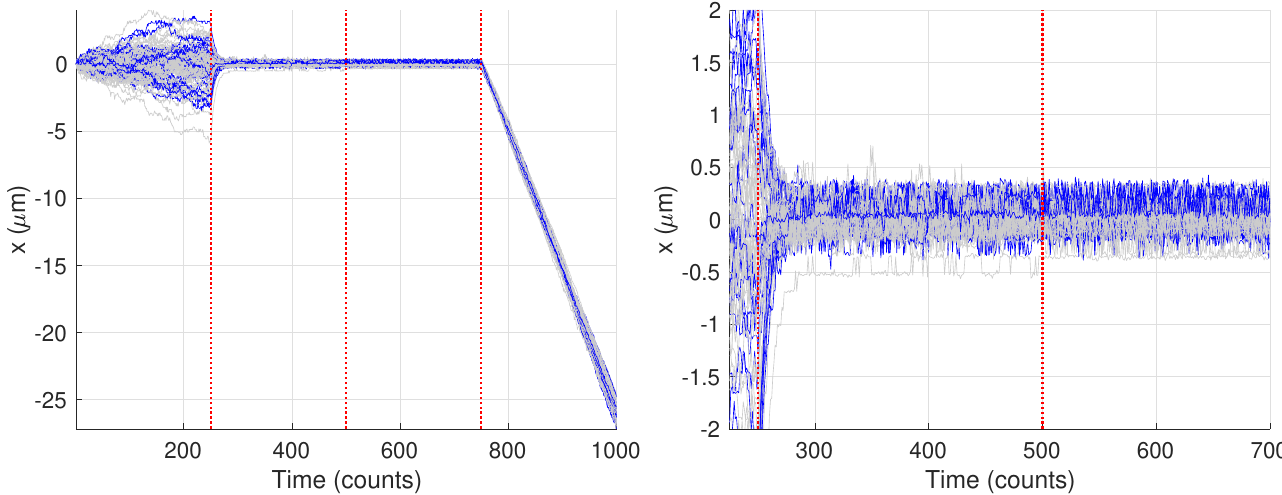
Figure 14. Synthetic motion trajectories generated from image data with the 26 trajectories yielding only two changes highlighted in blue. Vertical red dashed lines are where the model values changed. ( left ) Full trajectories. ( right ) Zoom in to highlight differences between the blue and gray